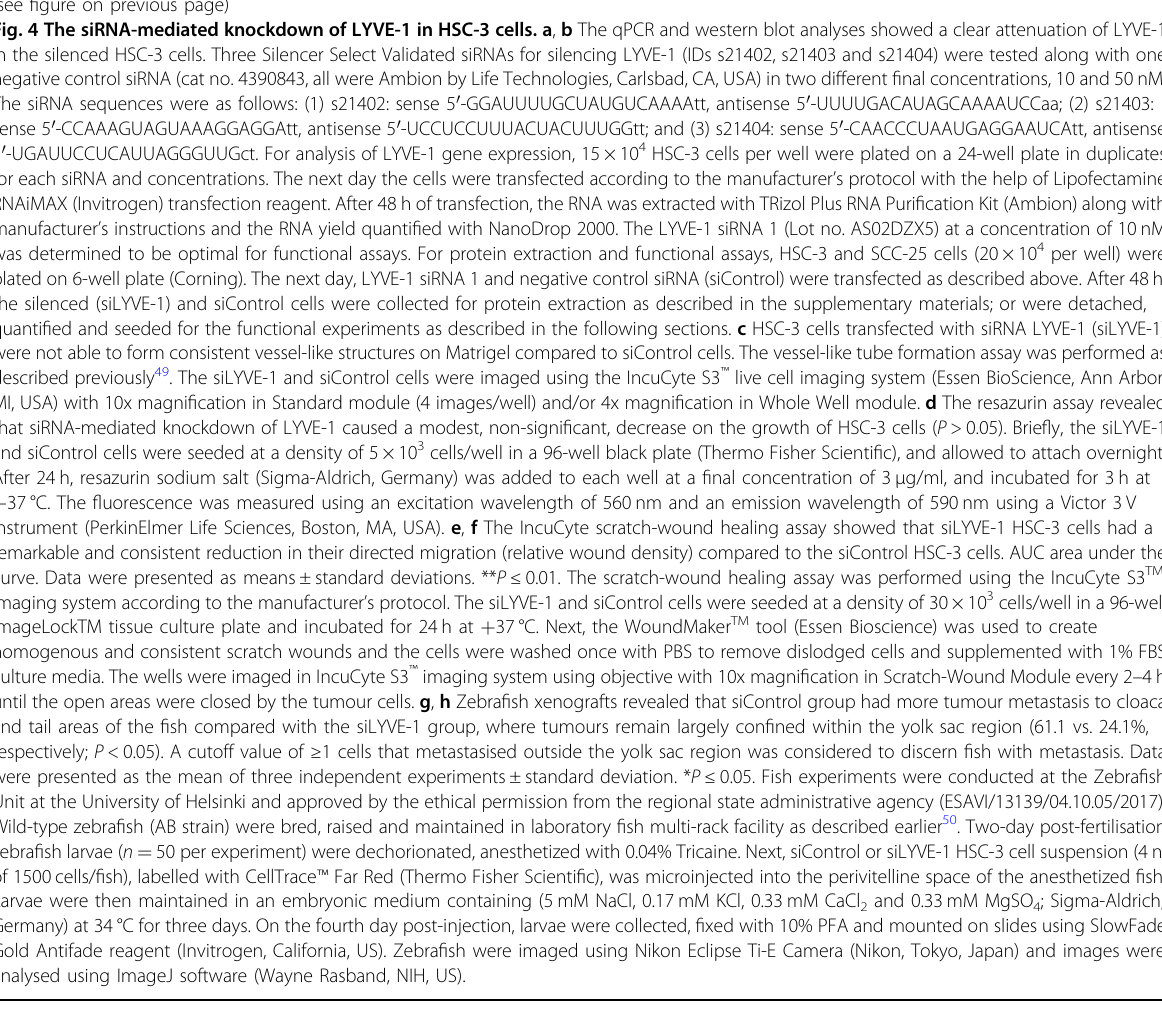
clinical samples are likely LM structures rather than